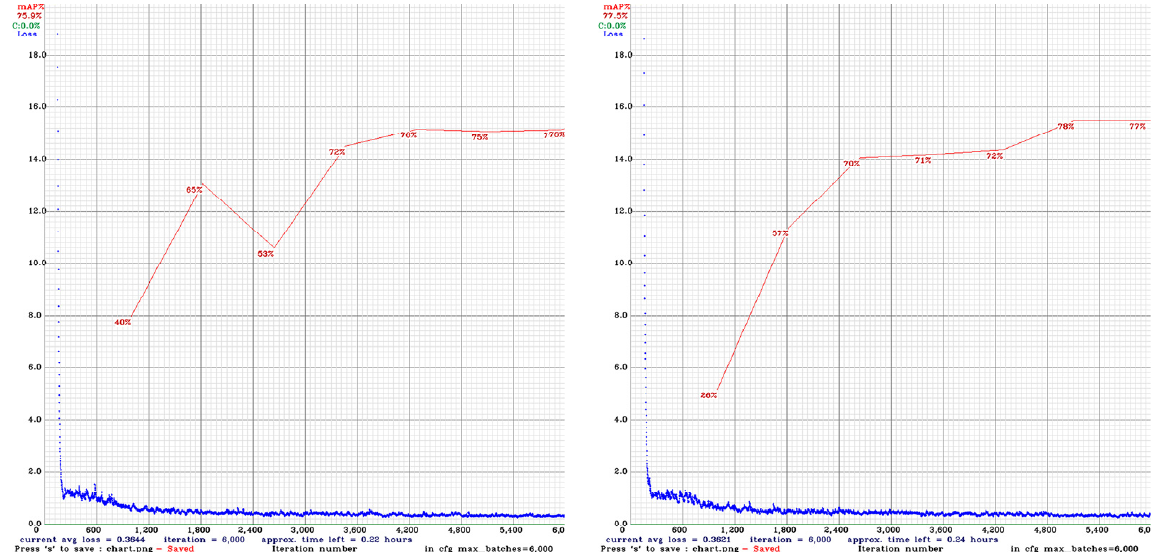
Figure 10. YOLO v4 on the left and our method on the right . Table 5. LEVIR dataset comparison results.